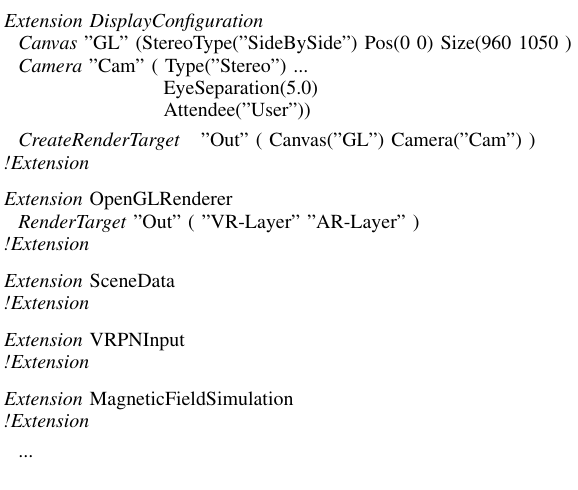
Fig. 10. Part of the VR configuration file used to load and configure all needed